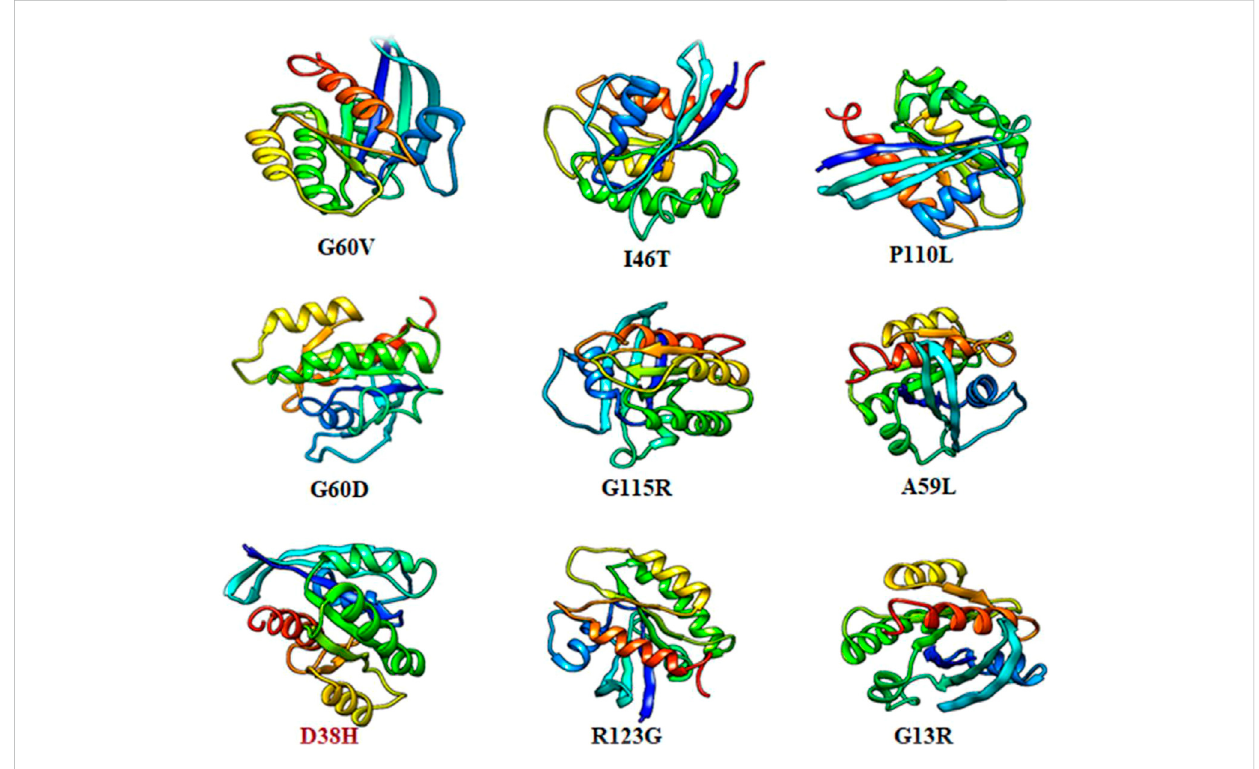
FIGURE 4 Muatantstructure of HRAS